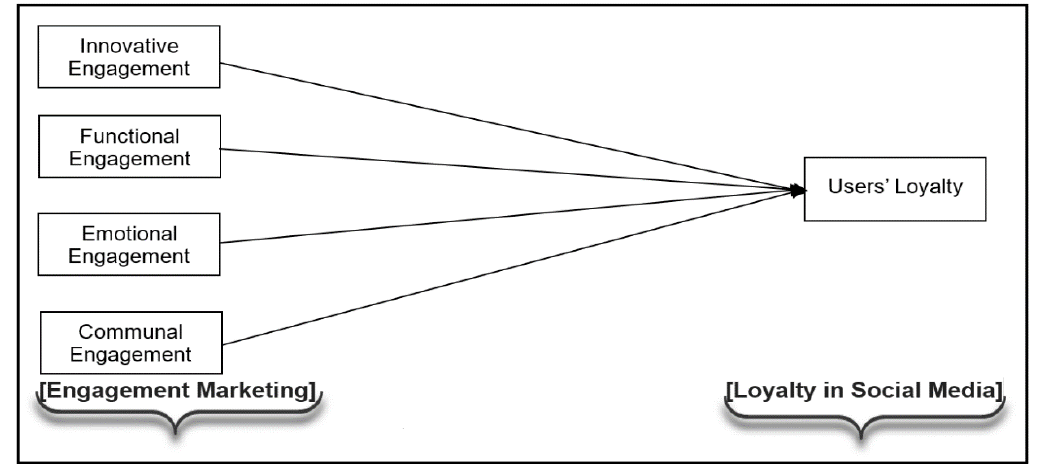
Figure 1. Proposed research model 1.